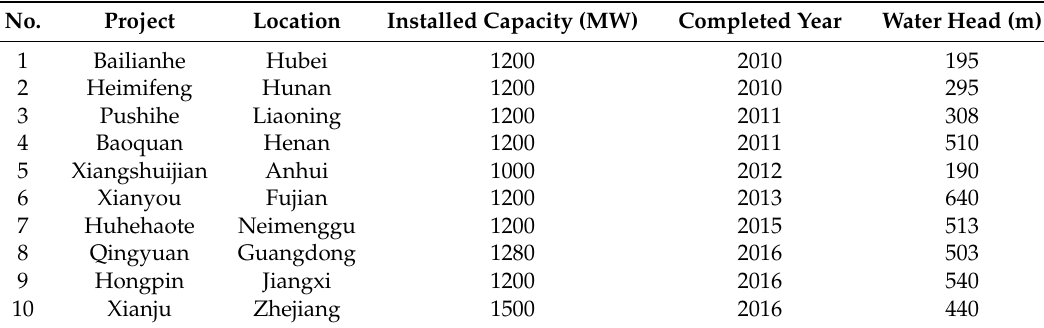
Figure 1. A pumped hydropower station layout. Table 1. Major pumped-storage power stations completed in China.